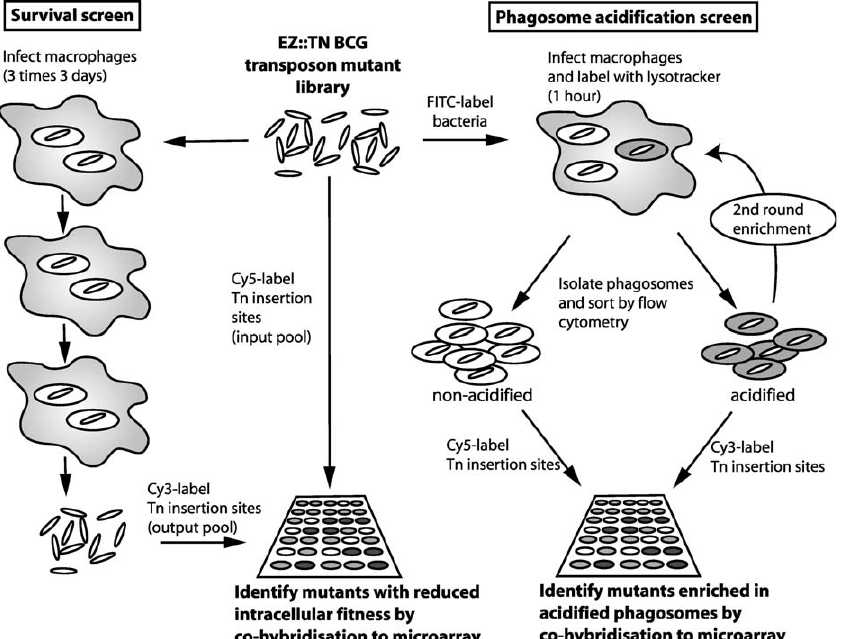
Figure 1. High-Throughput Screening for Mycobacterial Mutants with Reduced Survival in Macrophage Culture, or Defective Ability to Arrest Phagosome Acidification For the survival screen, the BCG transposon library was selected through three rounds of macrophage culture (72 h each) and survival of mutants assessed by fluorescent labelling of transposon insertion sites in input and output mutant pools and competitive hybridisation to a microarray. To screen for mutants unable to inhibit phagosome acidification, the transposon mutants were FITC-labelled and used to infect macrophages in the presence of LysoTracker for 1 h. Organelles were prepared and acidic phagosomes sorted by flow cytometry. Mutants in the acidic phagosomes were grown in broth and used for a second round of selection. The identity and abundance of mutants recovered from acidic and non-acidic phagosomes were compared by fluorescent labelling of transposon insertion sites and hybridisation to a